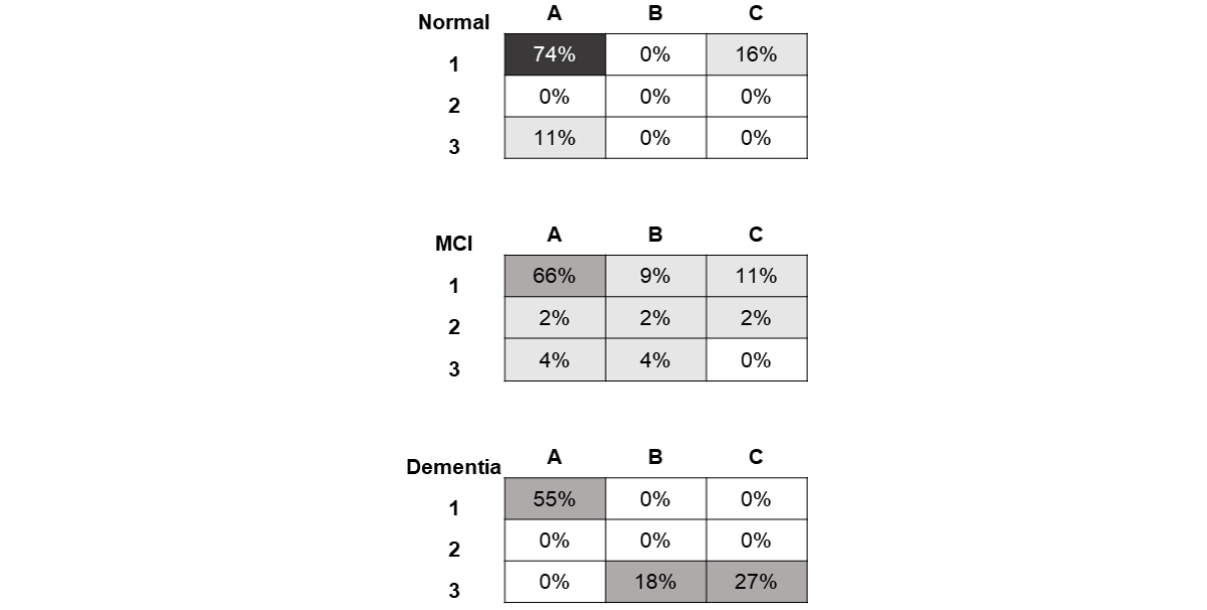
Figure 7. 1Bell for the 3 diagnosis groups (from top to bottom: normal, mild cognitive impairment, and dementia). For each group, the table represents the writing area of the tablet divided into 9 subareas and the percentage of subjects who started the scanning strategy in each subarea (1Bell). MCI: mild cognitive